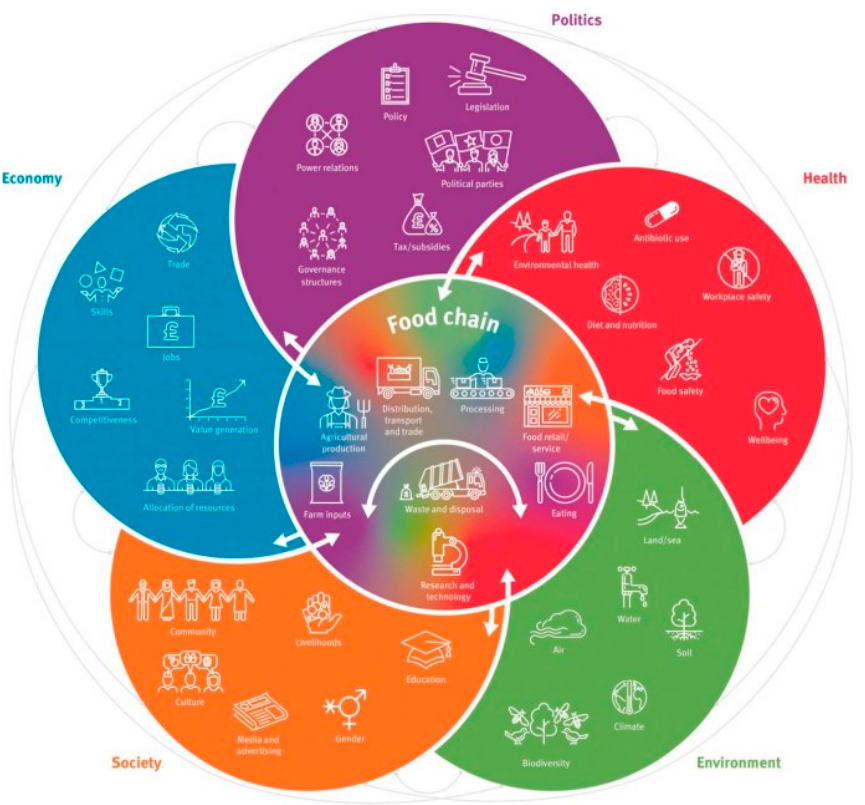
Figure 3. ‘ Domains within a sustainable food system framework’; reproduced from Tobi et al. [95].